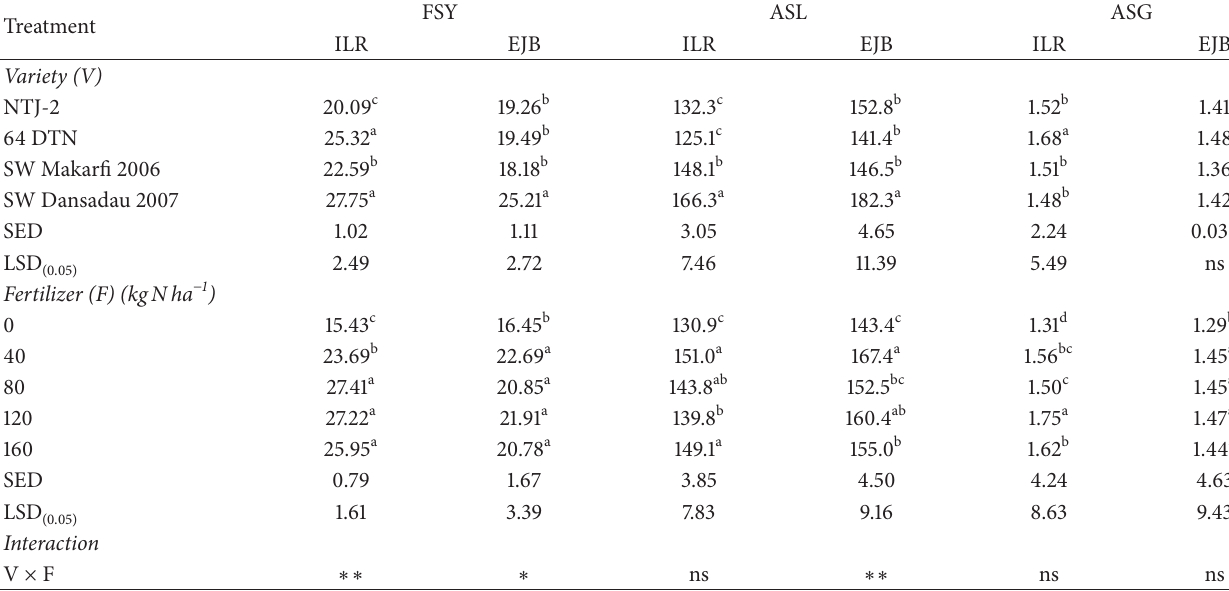
Table 4: Main effects of variety and N fertilizer on the fresh stalk yield (FSY, t ha −1 ), average stalk length (ASL, cm), and average stalk girth (ASG, cm) of sweet sorghum at the Ilorin (ILR) and Ejiba (EJB) experimental sites.